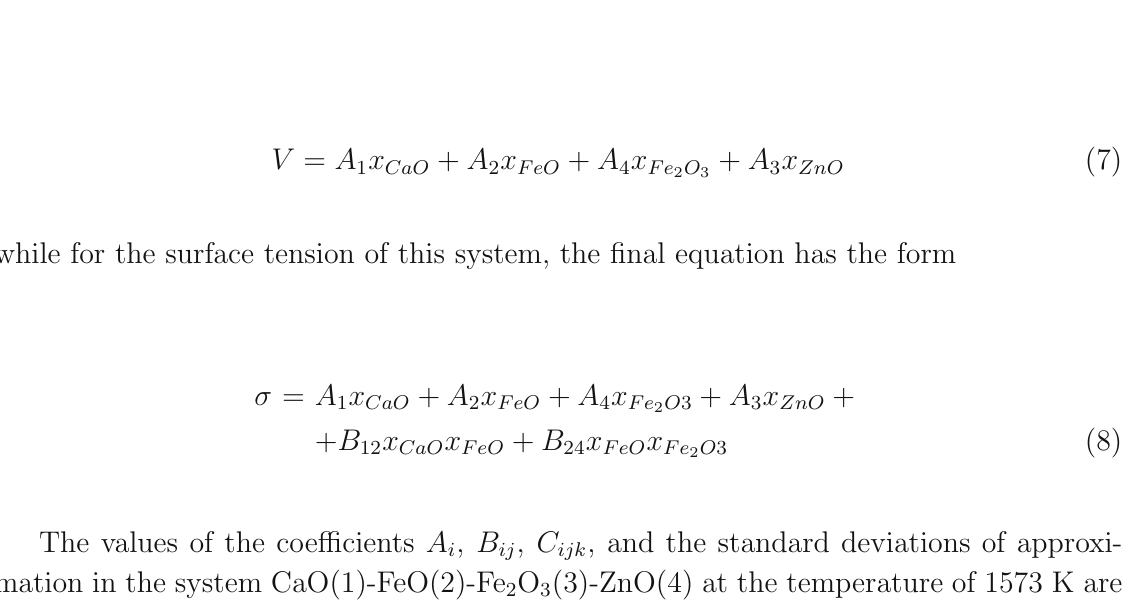
Fig. 4 Dependence of the surface tension of melts of the system CaO − FeO-Fe 2 O 3 -ZnO on the content of ZnO at the temperature of 1573